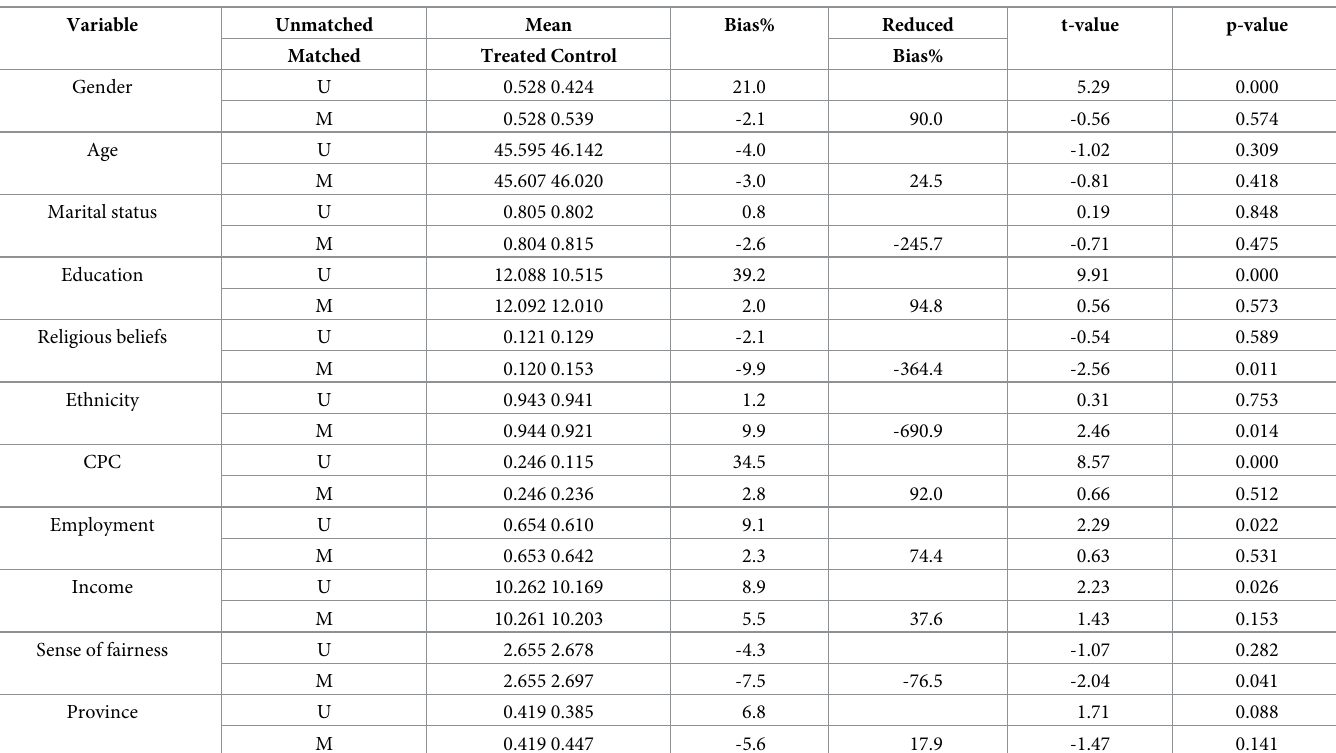
Table 4. Balance test.